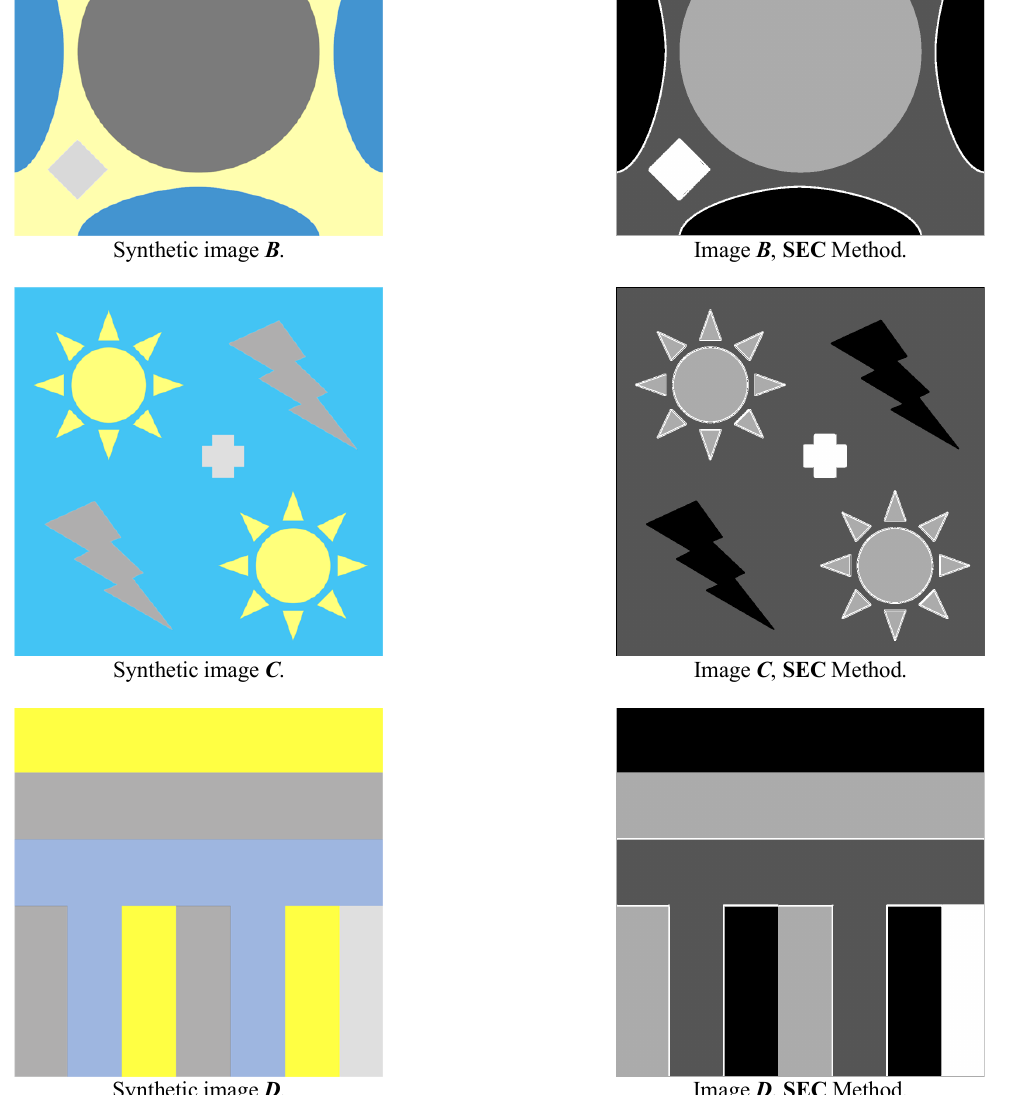
Figure 1. Synthetic images A , B , C and D (presented in false colour) and the classification results using the SEC